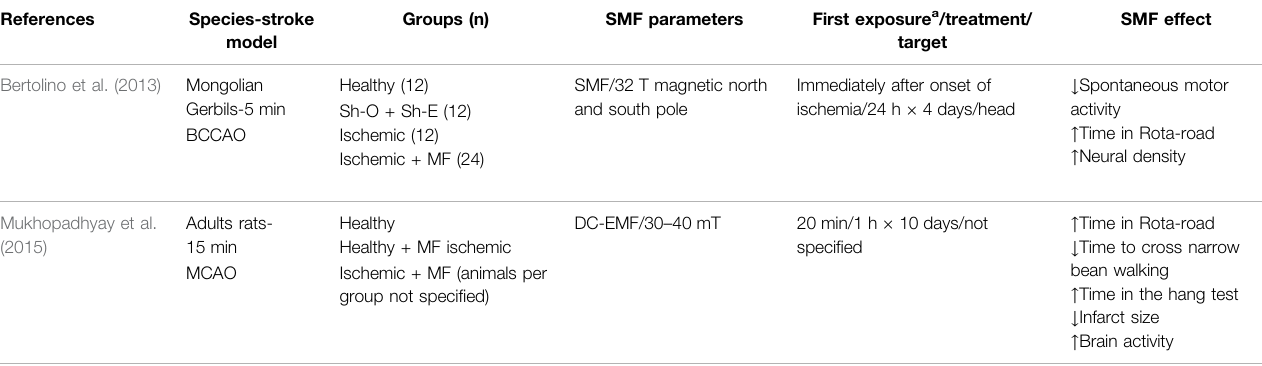
TABLE 1 | Overview of in vivo studies using static magnetic fi eld (SMF) as a treatment for